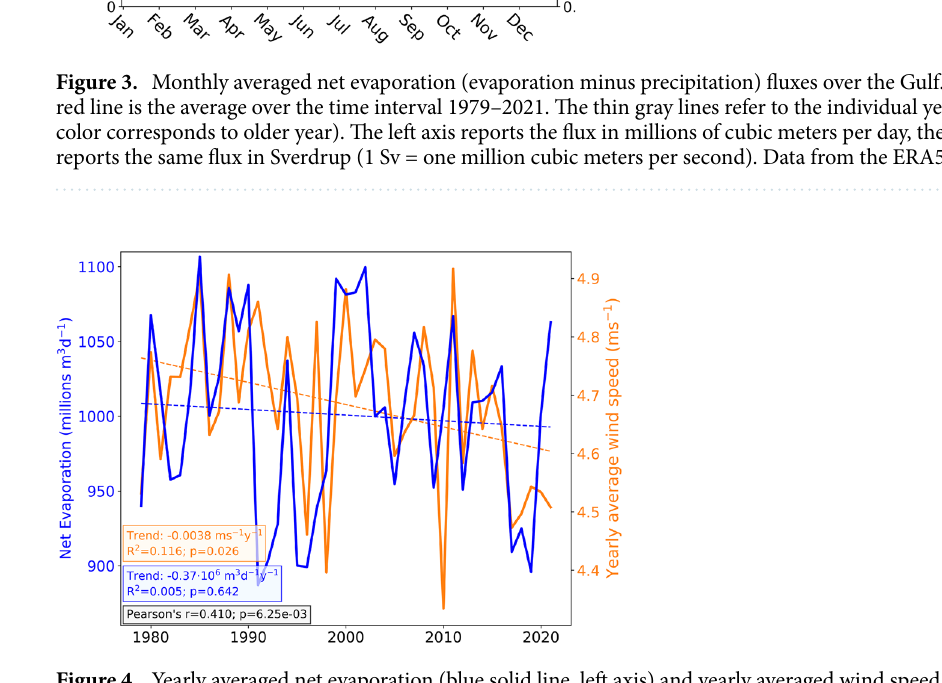
Figure 4. Yearly averaged net evaporation (blue solid line, left axis) and yearly averaged wind speed (orange solid line, right axis) over the Gulf. The dashed lines show the least-square linear fit to the data. The insets report the trend (slope of the linear fit) and the associated p-value respect to the null-hypothesis of zero trend. The Pearson’s correlation coefficient of the evaporation and wind time series and its p-value respect to the null- hypothesis of no correlation are also reported. Data from the ERA5 reanalysis 45